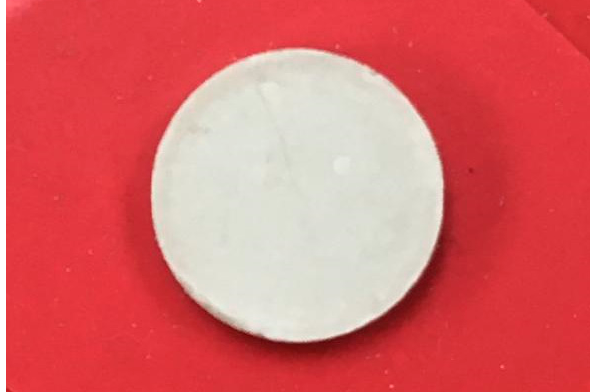
Figure 1. Sintered calcium oxide (CaO)-stabilized zirconia pellet blank.